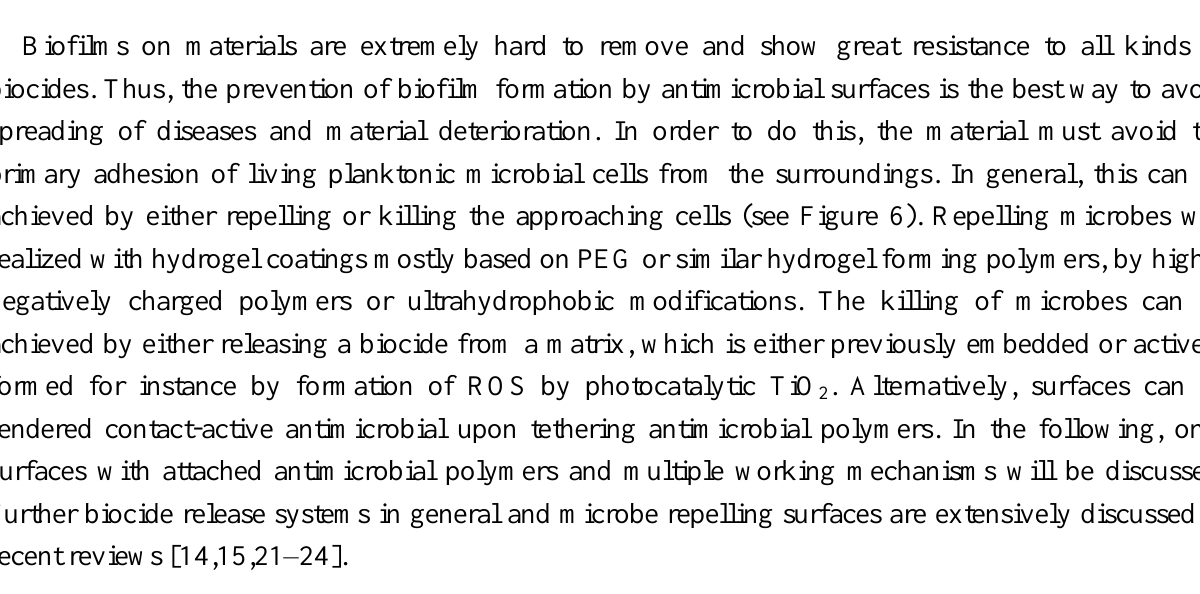
Figure 6. General principles of antimicrobial